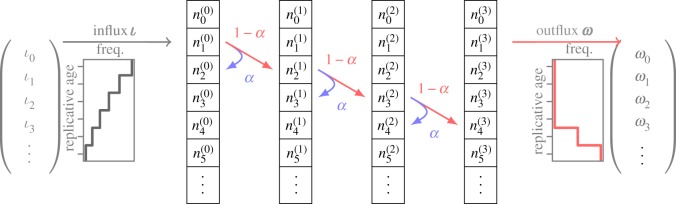
Several downstream compartments amplifying the rate of cell production from influx to outflux. In each compartment, there are self-renewal or differentiation processes as described in figure 1. Each cell division thereby leads to an increase of replicative age and changes the age distribution of the corresponding compartment. Self-renewal occurs proportional to the self-renewal parameter α, whereas differentiated cells are produced with 1 − α and go into the next downstream compartment. The compartment number c is shown as superscript, the total number of compartments is C = 4. (Online version in colour.)